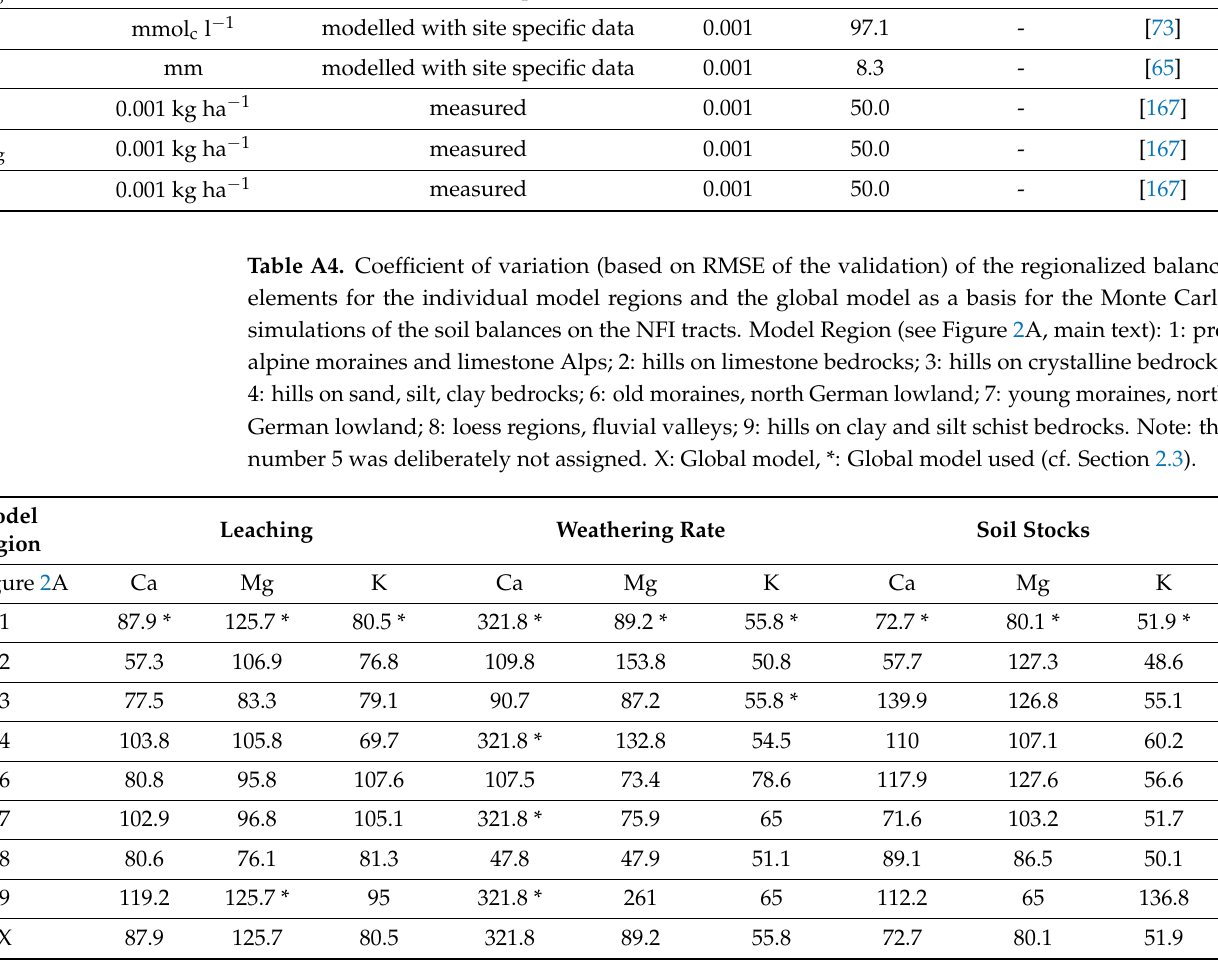
modelled with site specific data